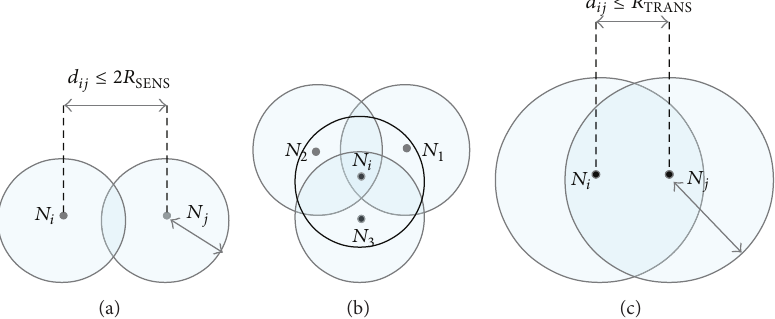
Figure 1: (a) Collaborating sensor nodes 𝑁 𝑖 and 𝑁 𝑗 , (b) sensor node 𝑁 𝑖 totally overlapped by sensor nodes 𝑁 1 , 𝑁 2 , and 𝑁 3 , and (c) communicating sensor nodes 𝑁 𝑖 and 𝑁 𝑗 .